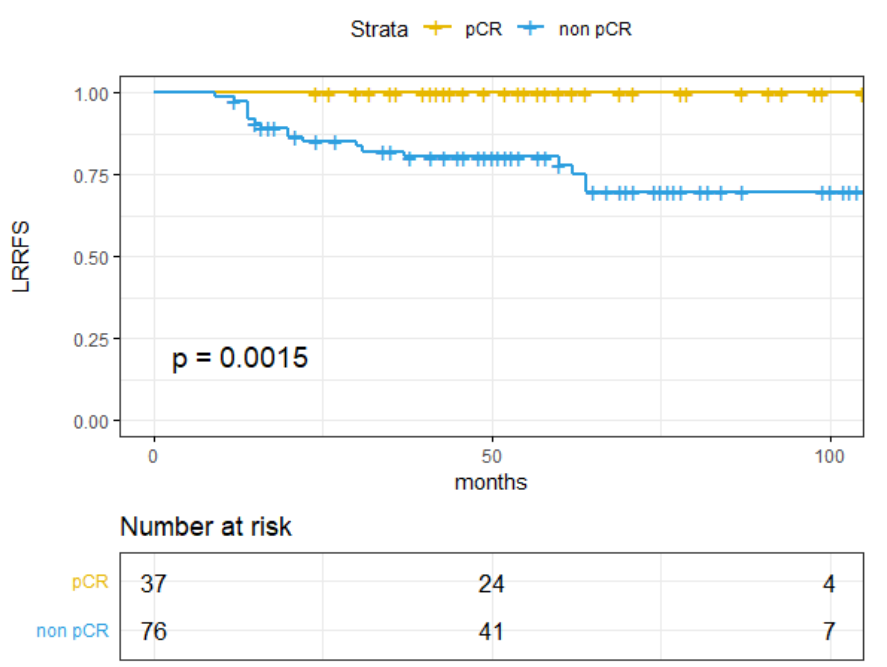
Figure A3. OS with adjuvant radiotherapy (5-y OS: 81.9% [74.1–90.6%]) vs. with preoperative radiotherapy (36.0% [15.0–86.5%]).